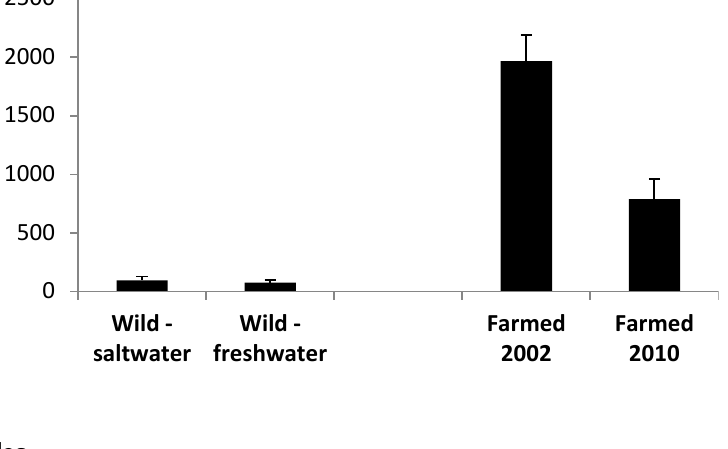
Figure 3. Content (±SD) (mg/100 g) of LC omega-3 oils (EPA + DPA + DHA) in